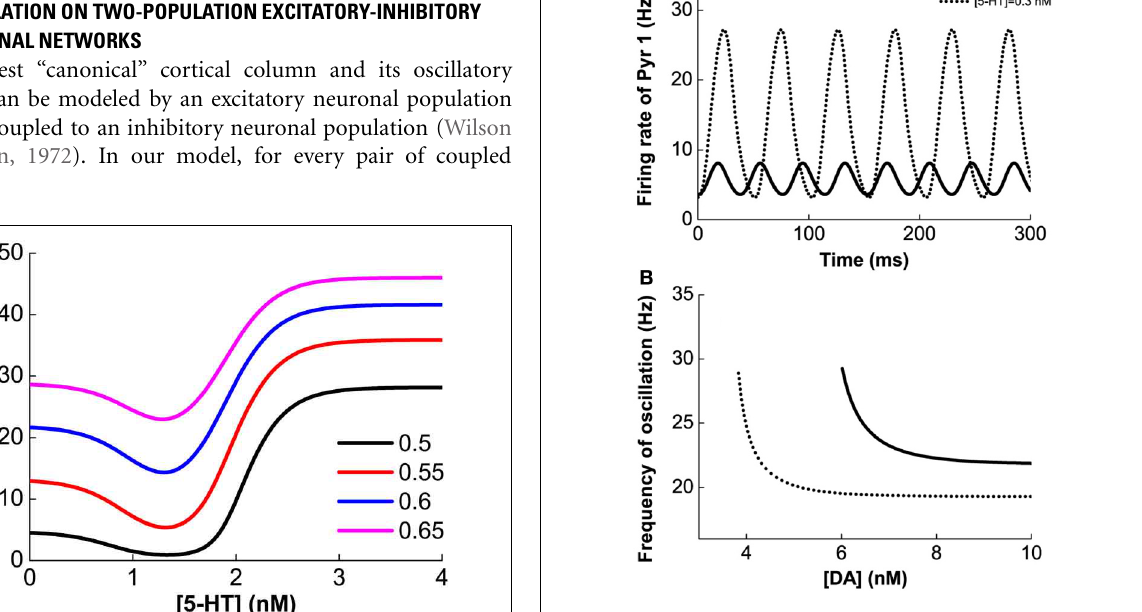
FIGURE 3 | Non-monotonic modulation of serotonin on the firing rate of a 5-HT1A and 5-HT2A coexpressing pyramidal cell given a fixed synaptic input, I syn . Colors denote different constant I syn values: 0 . 5, 0 . 55, 0 . 6 and 0 . 65nA.